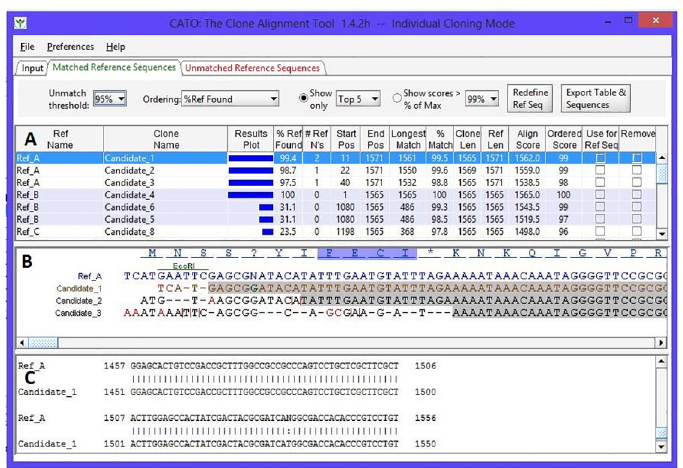
Fig 1. Main CATO interface. Results view with 3 panels showing the summary of reference sequences and matched candidate sequences are displayed in panel A. A focused view of a single reference sequence and associated clone candidate sequences is shown in panel B, with the highlighted candidate from the top panel colored brown. The top blue amino acid sequence has motifs highlighted. The blue nucleotide sequence is the reference sequence with restriction sites indicated. Candidate mismatch nucleotides are red, gaps indicated with a dash, and vertical red bars indicate 1 or more nucleotides missing from the reference. A grey background highlights the longest contiguous match with the reference sequence. A single reference- candidate sequence pair-wise alignment is in panel C.